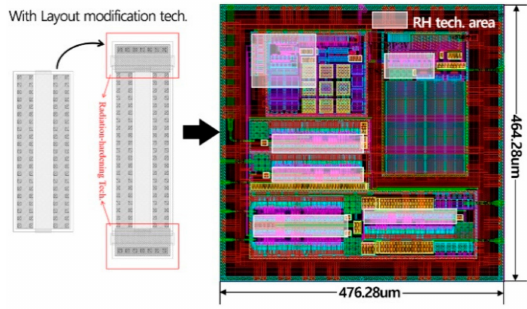
Figure 8. 2D layout drawing of the radiation-hardened IA.